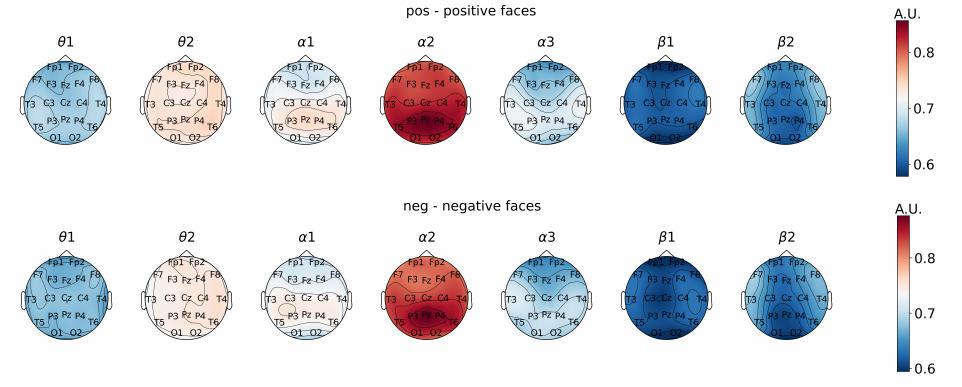
Figure 6. Topographical distribution of DMA scaling exponent values.